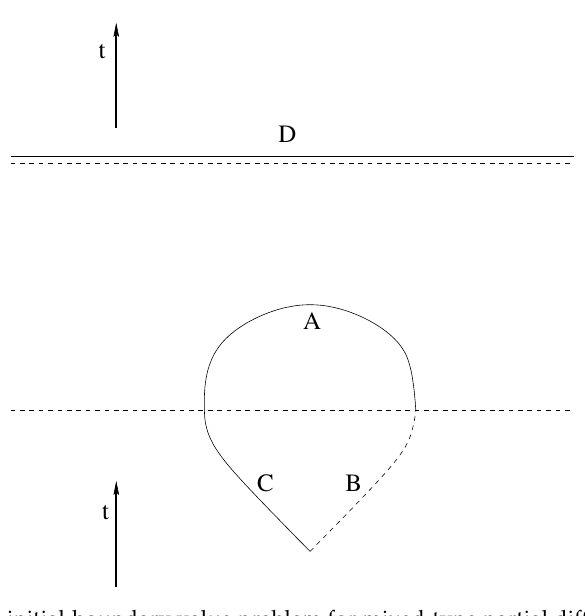
Figure 1. Well-posed initial-boundary value problem for mixed-type partial differential equations in two dimensions, according to Tricomi [86]. Arrows indicate the assumed flow of time in Lorentzian regions, while the two horizontal dashed lines are transition surfaces between two Lorentzian regions (top and bottom) and a Euclidean central region, as it may be realized at the center of a bouncing cosmological or black-hole solution. Entering the Euclidean region (bottom), the Tricomi problem shows that smooth data for the field (but not its normal derivatives) posed on the union of one characteristic in the original Lorentzian region (C) as well as an arc (A) in the Euclidean region connecting the end point of C with the end point of the other characteristic (B) starting at the same point as C imply a unique smooth solution in the region bounded by A, B and C, which depends continuously on the data. The solution cannot be freely specified on B. Data on A amount to final values as seen from the flow of time in the initial Lorentzian region. On the other side of the Euclidean region, top, the flow of time points away from the transition surface. A standard initial-value problem can therefore be used on any equal-time hypersurface (D) after the transition (“after” defined according to the flow of time in the Lorentzian region pointing away from the Euclidean region). In this initial-value problem, both the field and its normal (that is, time) derivative can be chosen freely on